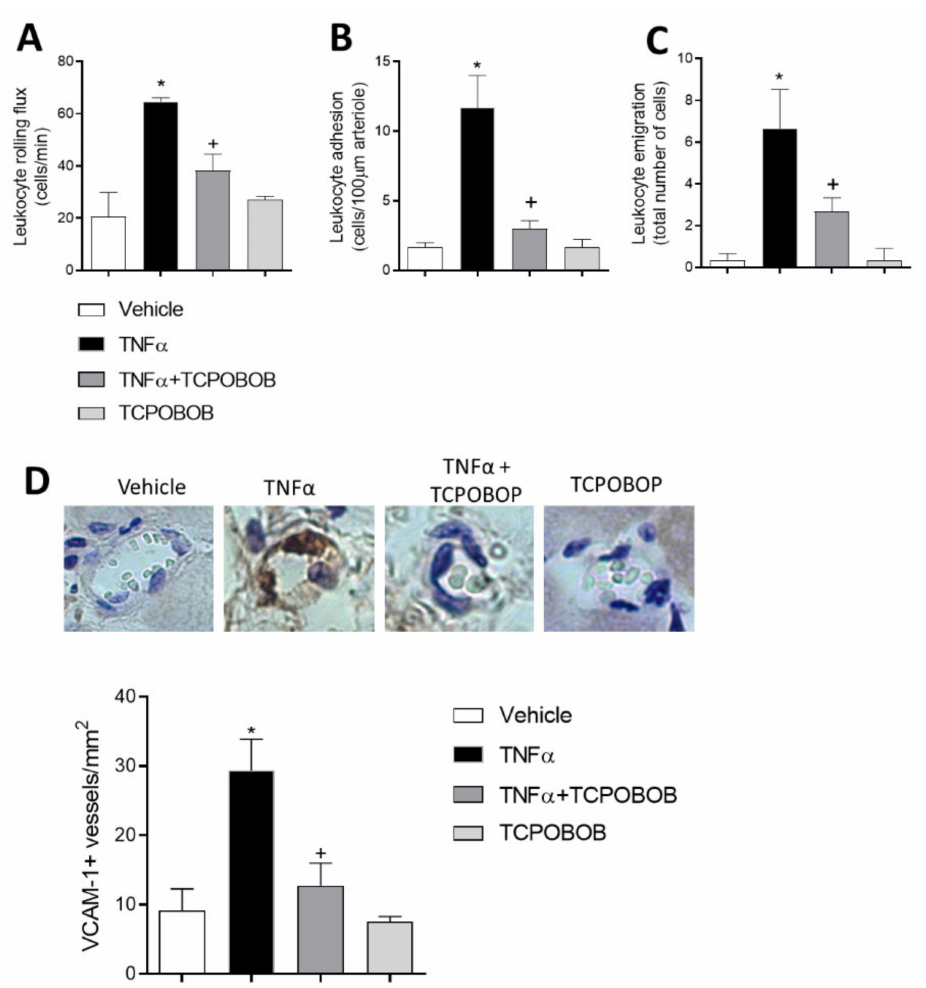
Figure 6. CAR activation inhibits leukocyte recruitment in murine cremasteric microvessels. Mice were treated for 24 h with TCPOBOP (3 mg/kg, i.p) or vehicle prior to TNF- α stimulation (0.5 µ g/mouse, intrascrotal injection, 4 h) and leukocyte rolling ( A ), adhesion ( B ) and emigration ( C ). The results represent five experiments with each treatment. Some cremasters were fixed for microvessel staining with anti-VCAM-1 antibody. Immunolocalization of VCAM-1 on the vascular endothelium ( D ). Results are representative of three experiments with each treatment. * p < 0.05 relative to the vehicle group, + p < 0.05 relative to the TNF α -treated